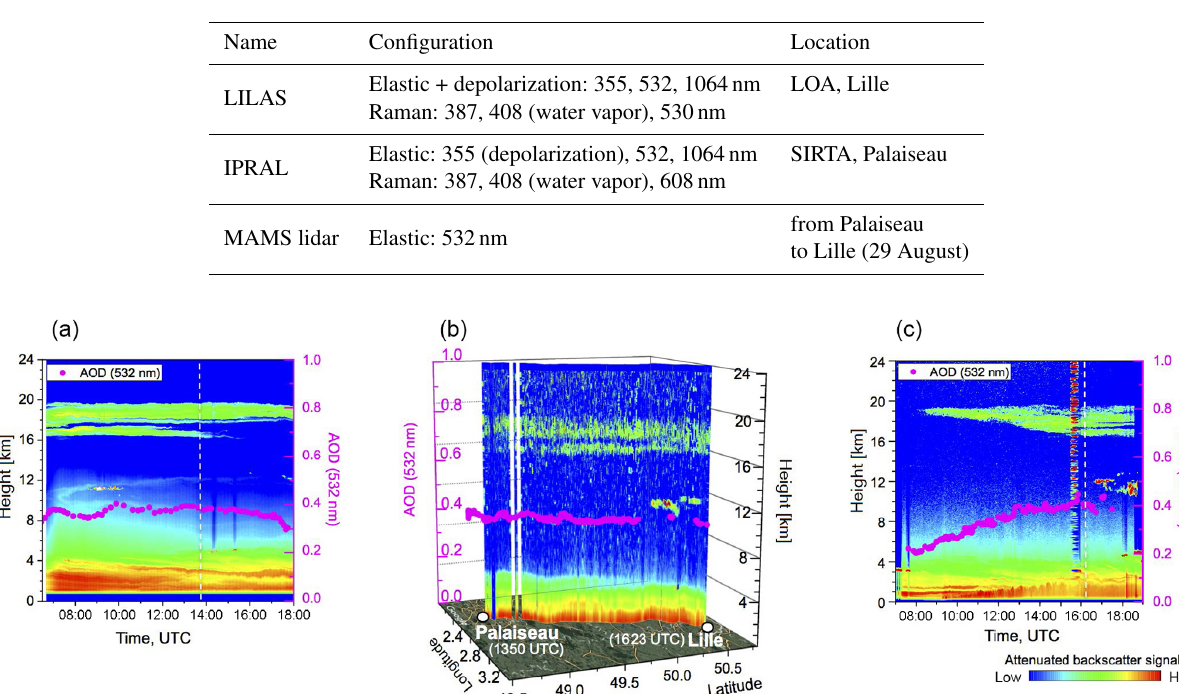
Table 1. Three involved lidar systems and their configuration and locations.